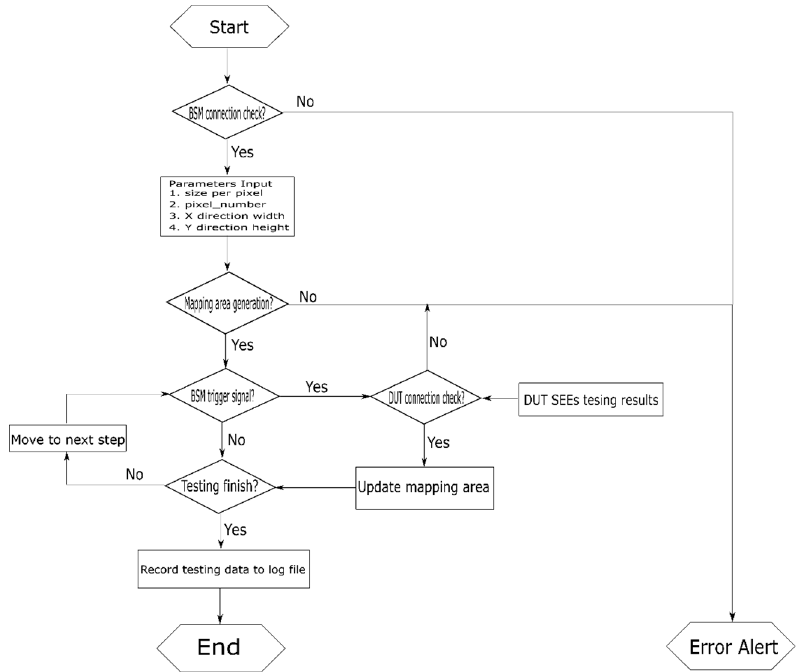
Figure 11. Data flow of the mapping program.